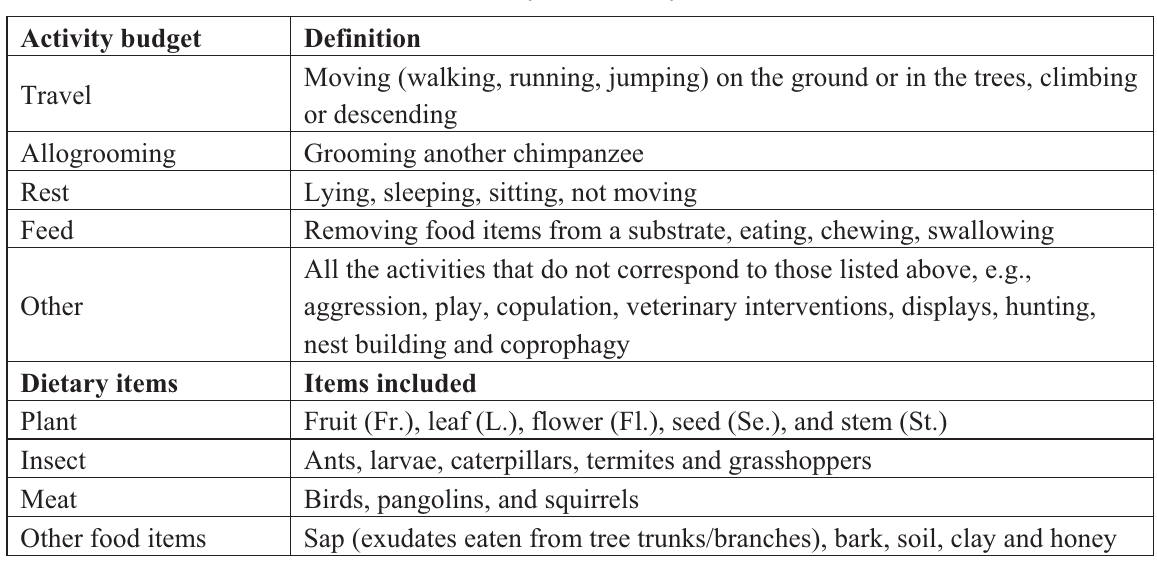
Table 2. Activity and dietary